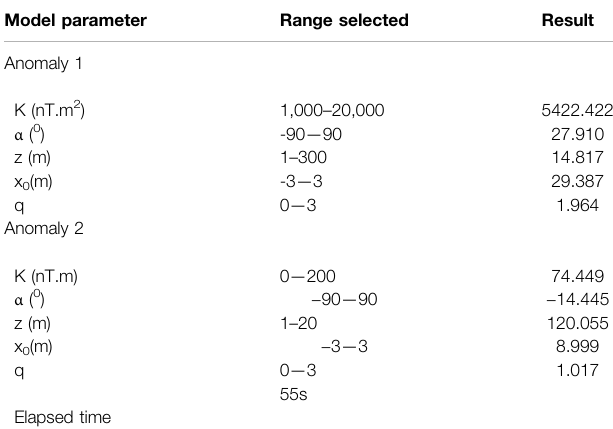
TABLE 4 | Selected ranges of model parameters and numerical results for the synthetic multimodal anomaly example. Model parameter Range selected